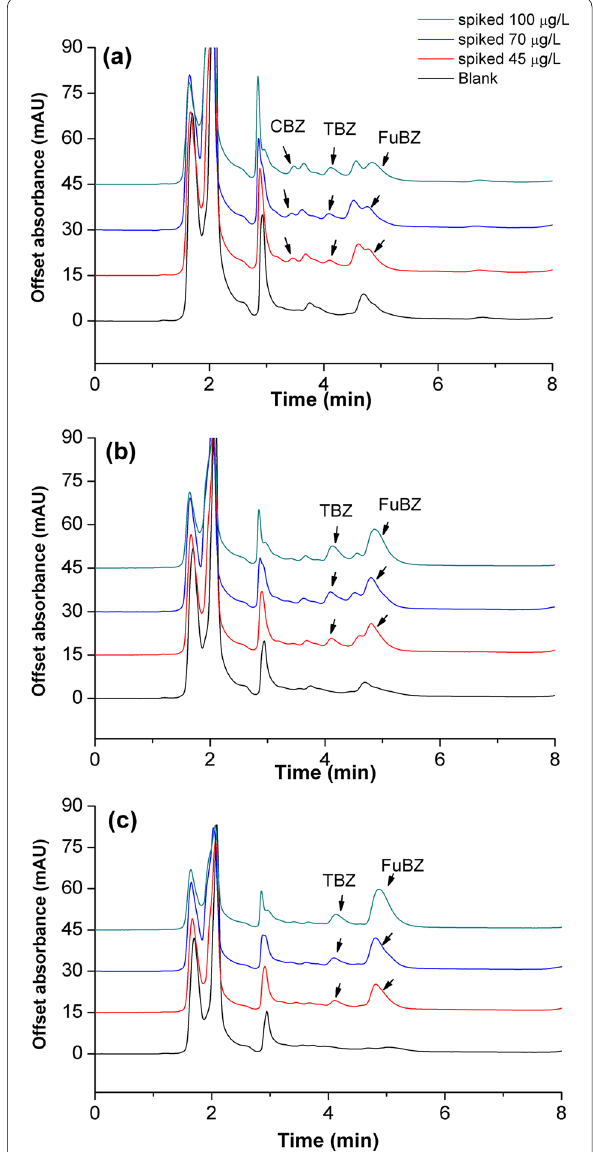
Fig. 9 Overlaid chromatograms of red apple juice samples with no spiking and those spiked with different concentrations of target fungicides obtained at a 281 nm, b 302 nm, and c 313